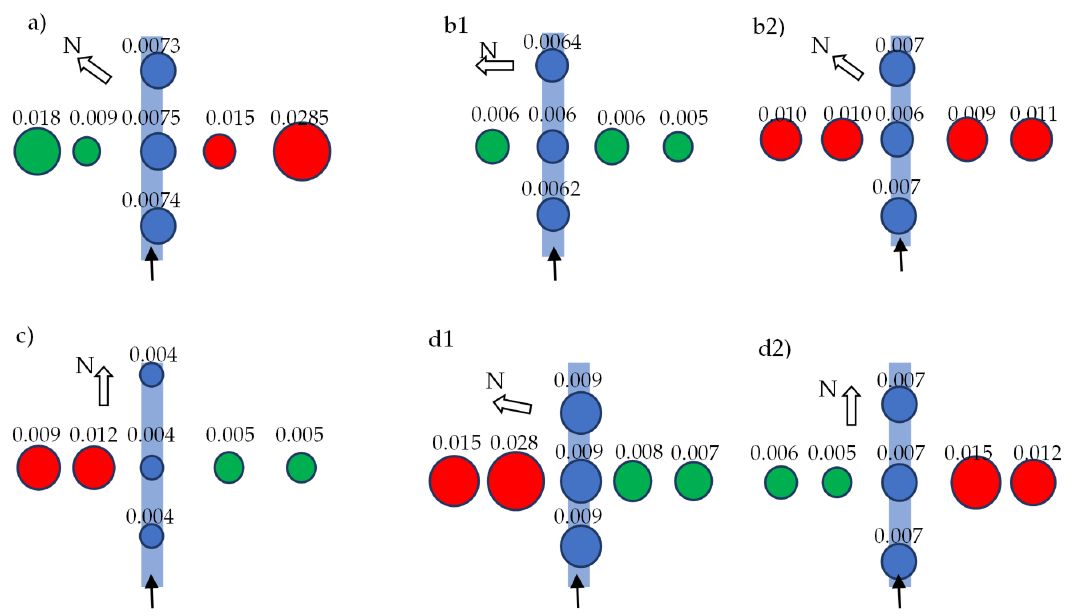
Figure 8. Phosphate phosphorus (PO 4 -P) concentrations in the groundwater of rivers and boreholes. Blue dots refer to the surface water samples, green dots refer to the ground water samples taken in organic farming areas and red dots refer to the ground water samples taken in intensive farming areas: ( a ) Alšia, ( b1 ) and ( b2 ) Žem ė pl ė ša, ( c ) Šuoja, ( d1 ) Romatas and ( d2 ) Lomena.